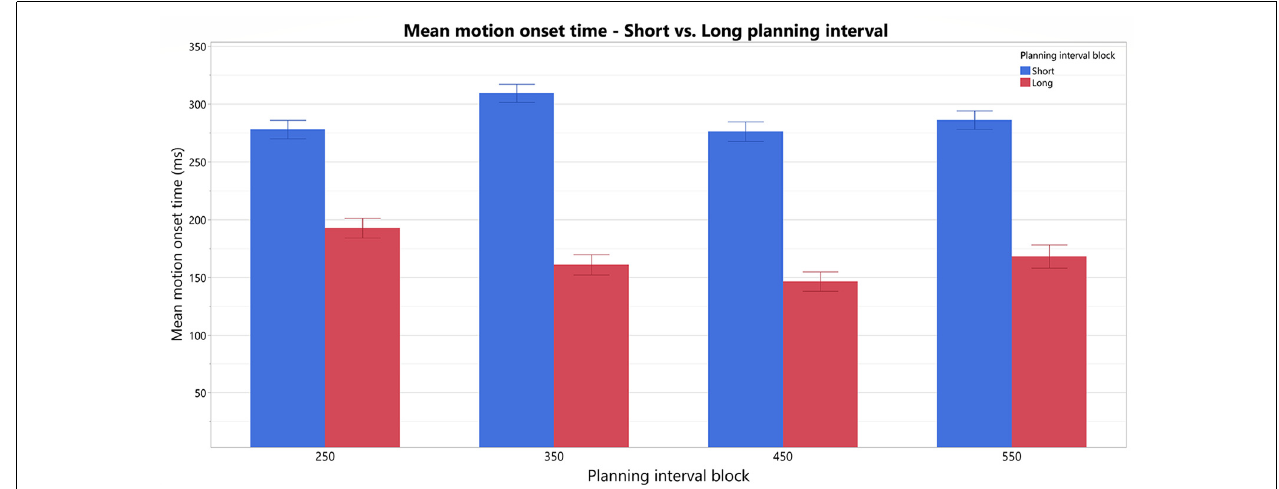
FIGURE 3 | Comparison of motion-onset Start times in Short vs. Long planning-interval trials in each of the blocks. There is an overall significant difference between Short and Long planning-interval